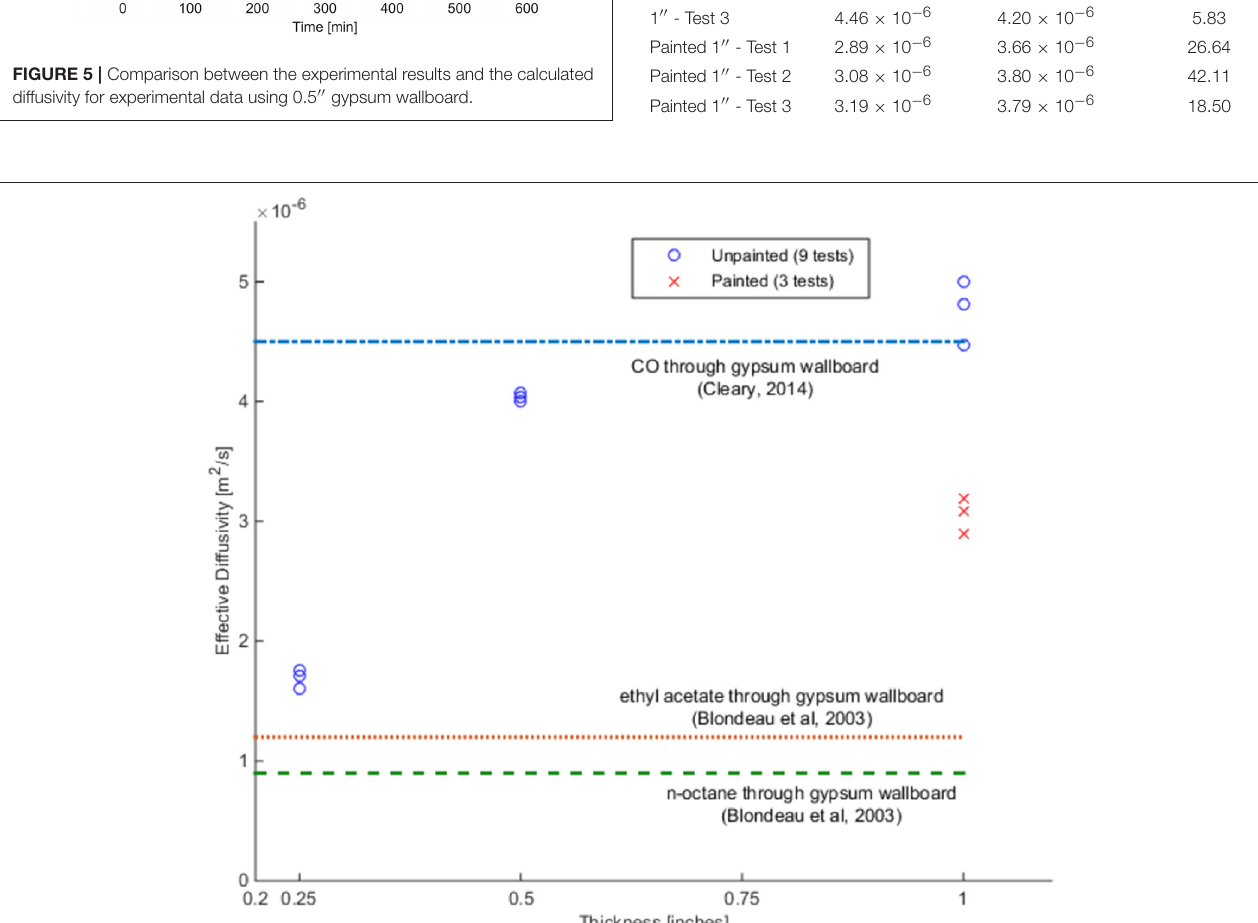
FIGURE 6 | Comparison of mean diffusivities for the 12 experiments, along with values from literature.